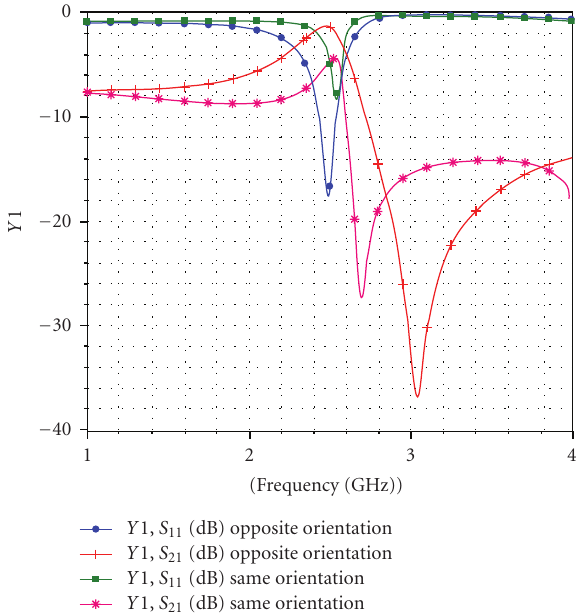
Figure 13: Simulated magnitude response of hair-pin resonator filter having two orientations with parallel coupled-feed lines.